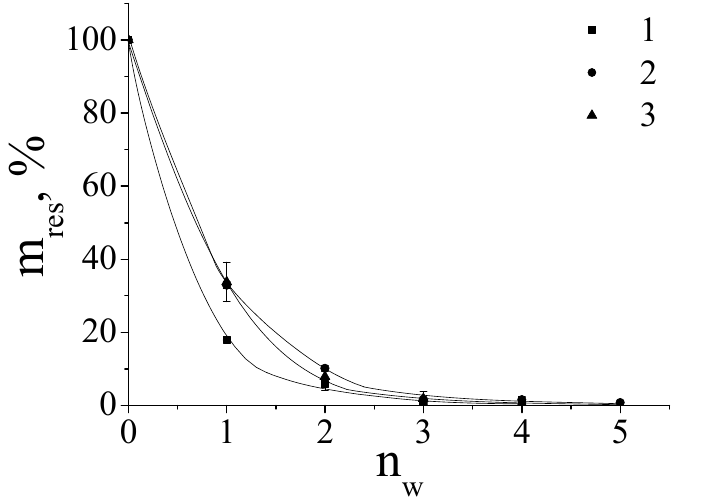
Figure 1. Dependence of the percentage of residual mass of coatings (m res ) formed from PDADMAC 100 (1), PDADMAC 200 (2) and PDADMAC 400 (3) on the number of wash ‐ off cycles (n w ).